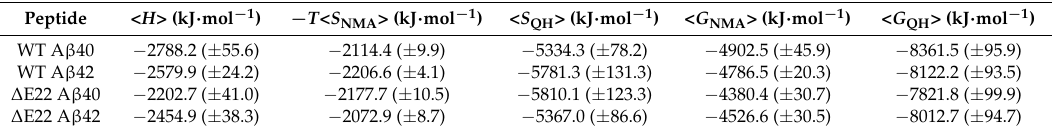
Table 4. Calculated mean values of enthalpy ( H ), entropy ( TS ) and Gibbs free energy ( G ) for the WT and ∆ E22 mutant A β 40 and A β 42 peptides using the normal mode analysis ( S NMA ) and Schlitter ( S QM ) methods to calculate the entropic contribution to G